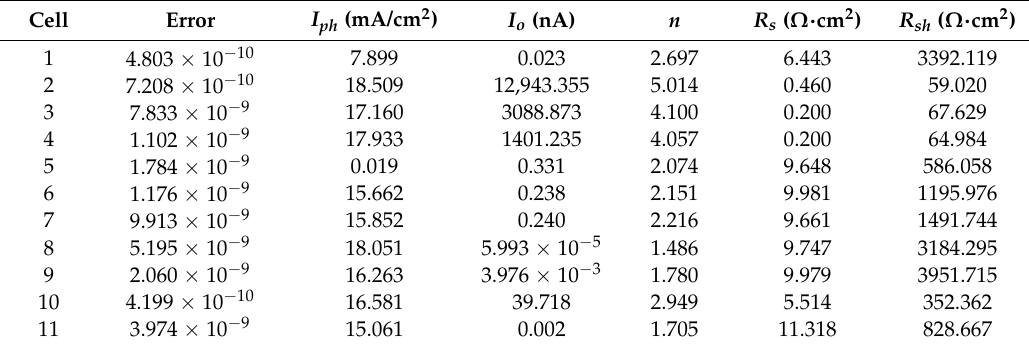
Table 5. One-diode parameters for Perovskite solar